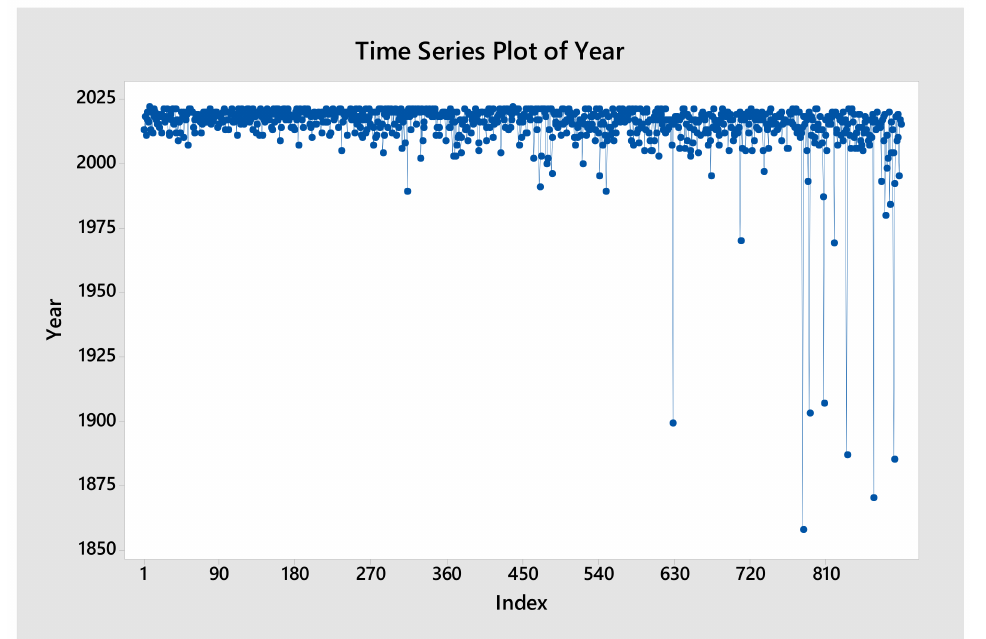
Figure 3. Journal search results (Time Series Plot of